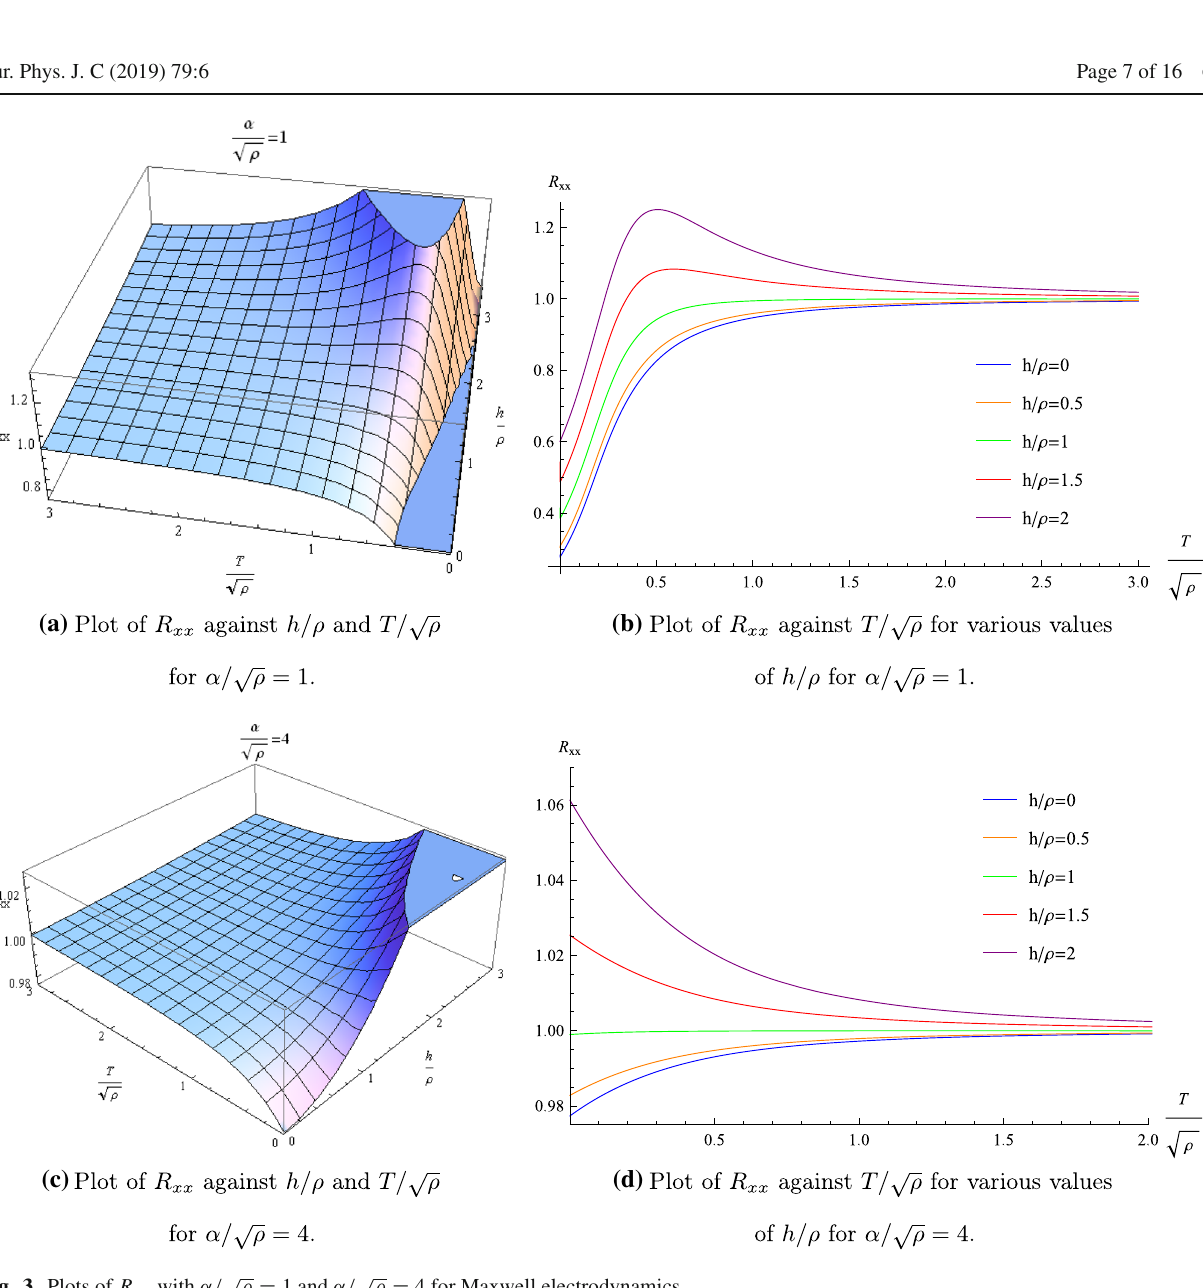
Fig. 3 Plots of R xx with α/